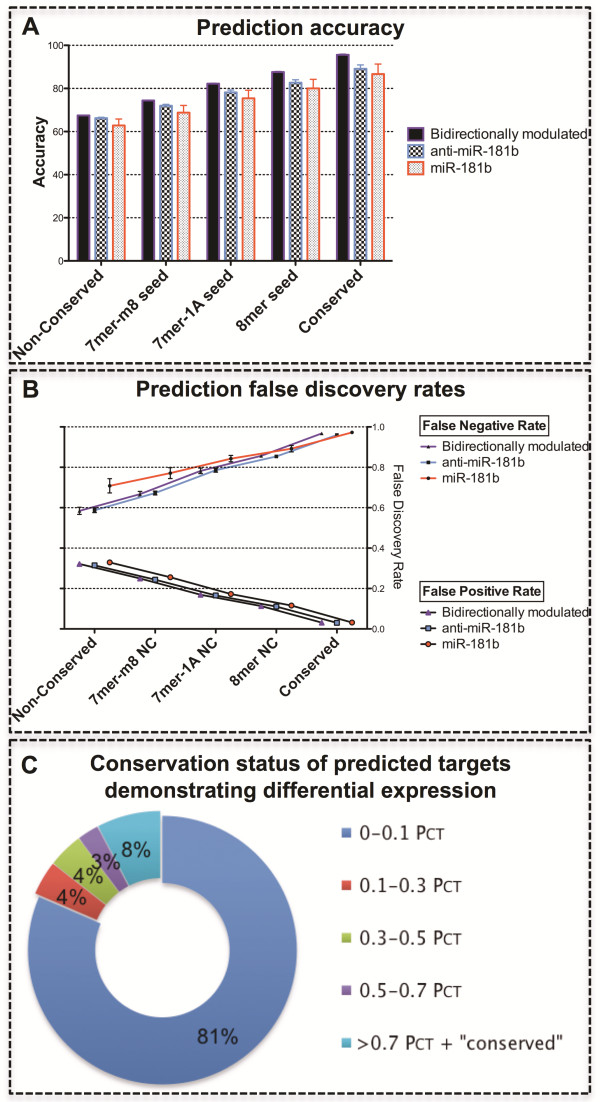
The performance of conserved and non-conserved target predictions across multiple biological datasets. Panel A illustrates the accuracy with which modulated genes were correctly predicted as either targets or non-targets by Targetscan. Error bars were calculated using the mean, N, and standard deviation across HEK-293, HeLa, and SH-SY5Y datasets. Panel B illustrates the false discovery rates associated with Targetscan’s prediction of genes modulated subsequent to altered miRNA expression. A false negative indicates a gene differentially expressed with miRNA modulation, but not a predicted miR-181b target; and a false positive indicates a predicted miR-181b target that is not differentially expressed with miRNA modulation. Error bars were calculated using the mean, N, and standard deviation across HEK-293, HeLa, and SH-SY5Y datasets. Panel C shows the conservation status of predicted target genes modulated in response to altered miR-181b expression. The values in this figure represent the average values across both miR-181b over-expression and inhibition in HEK-293, HeLa, and SH-SY5Y cell types. PCT: Probability of conserved targeting; the lower the probabilistic value, the poorer the conservation of the predicted binding site across multiple species.